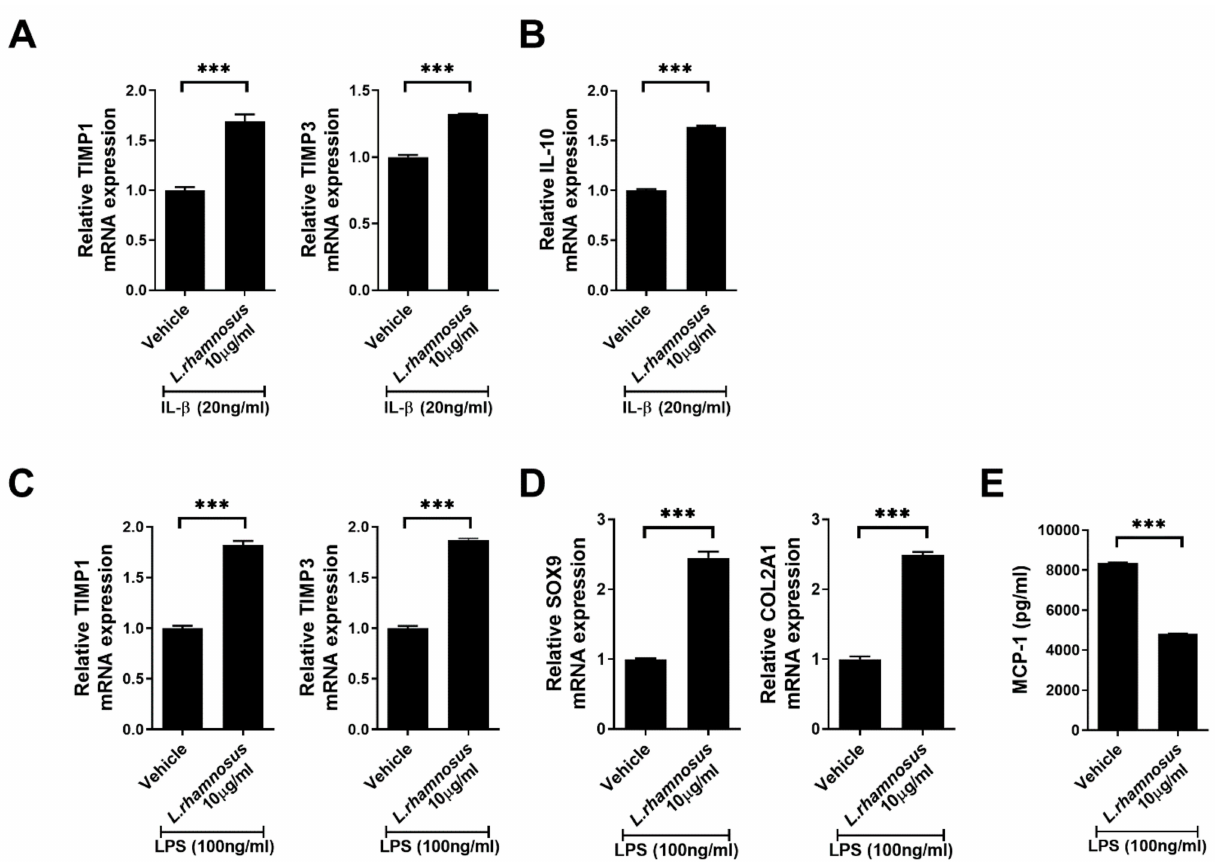
Figure 6. Human articular chondrocytes from OA patients were cultured with IL-1 β and LPS in the presence or absence of L. rhamnosus (LR-2) for 48 h, following 24 h in serum-free medium. The mRNA expression levels of anabolic factors, tissue inhibitors of ( A ) metalloproteinase (TIMP)-1, TIMP-3, and ( B ) IL-10 were measured by quantitative real-time PCR; β -actin was used as an internal control. The transcripts expression levels of anabolic factors TIMP-1 and TIMP3 ( C ), chondrogenic transcription factors SOX9 and COL2A1 ( D ). ( E ) The concentrations of MCP-1 were measured by enzyme- linked immunosorbent assay. Data are presented as the mean ± SD of three independent experiments. *** p <